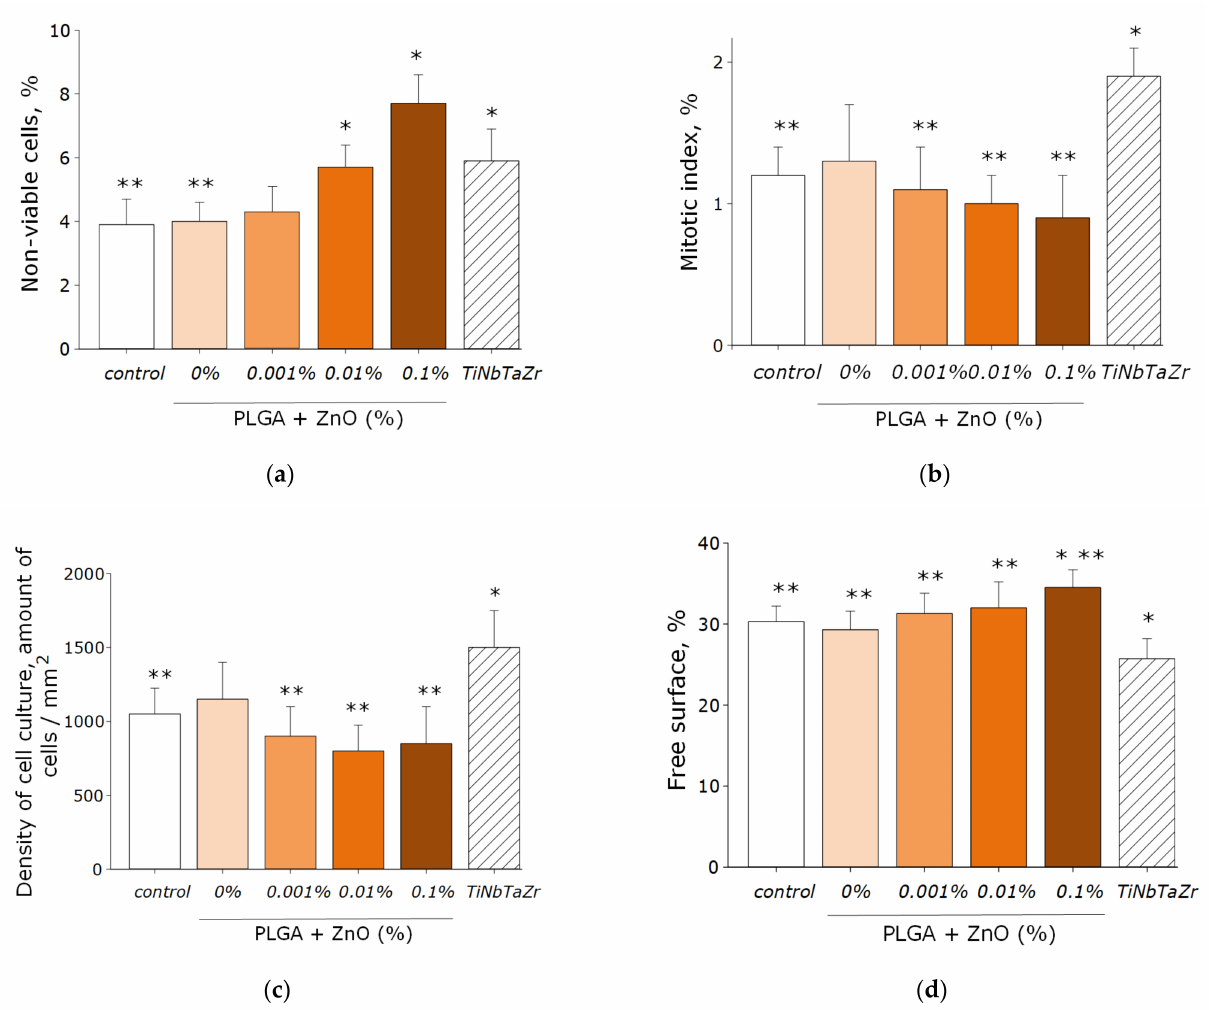
Figure 10. The effect of the PLGA/NP composite on the main characteristics of the growth and development of cell culture after 72-h cultivation: ( a ) Influence of composite material on the viability of cell culture; ( b ) Influence of composite material on the mitotic index of a cells; ( c ) Influence of composite material on the cell culture density; ( d ) Influence of composite material on the colonization rate of free surface by cells. * indicate a significant difference at 5% level in comparison with the control ( p < 0.05). ** indicate a significant difference at 5% level in comparison with the TiNbTaZr group ( p < 0.05). Data are presented as mean values and standard errors of